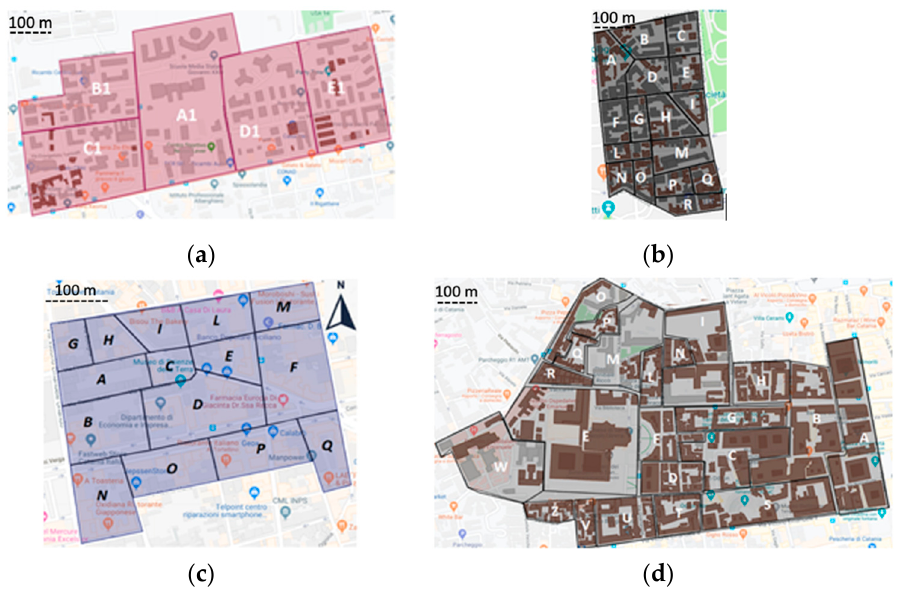
Figure 7. Division of the areas in blocks according to the urban morphology: ( a ) west area; ( b ) northeast area; ( c ) north Old Town; ( d ) south Old Town.